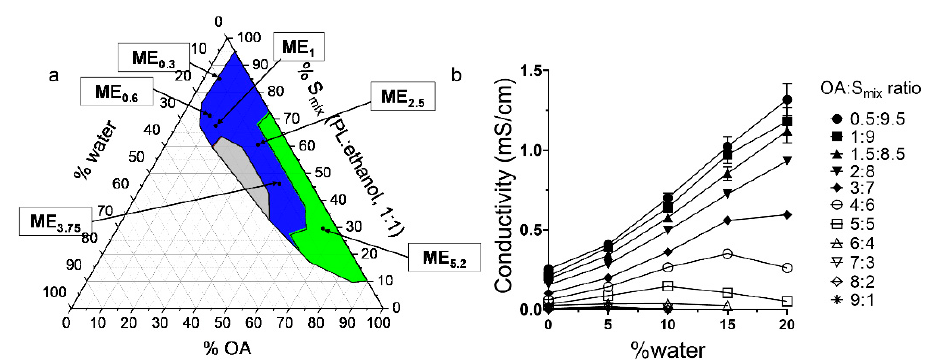
Figure 1. Characterization of the studied MEs. ( a ) Pseudo-ternary phase diagram; the coloured area represents the ME region (green represents w / o MEs, blue bicontinuous MEs, and grey the o / w MEs). The compositions of selected MEs are highlighted. ( b ) Electrical conductivity of MEs of varying OA: S mix ratios as a function of water concentration. Table 1. Composition (weight%) of the studied